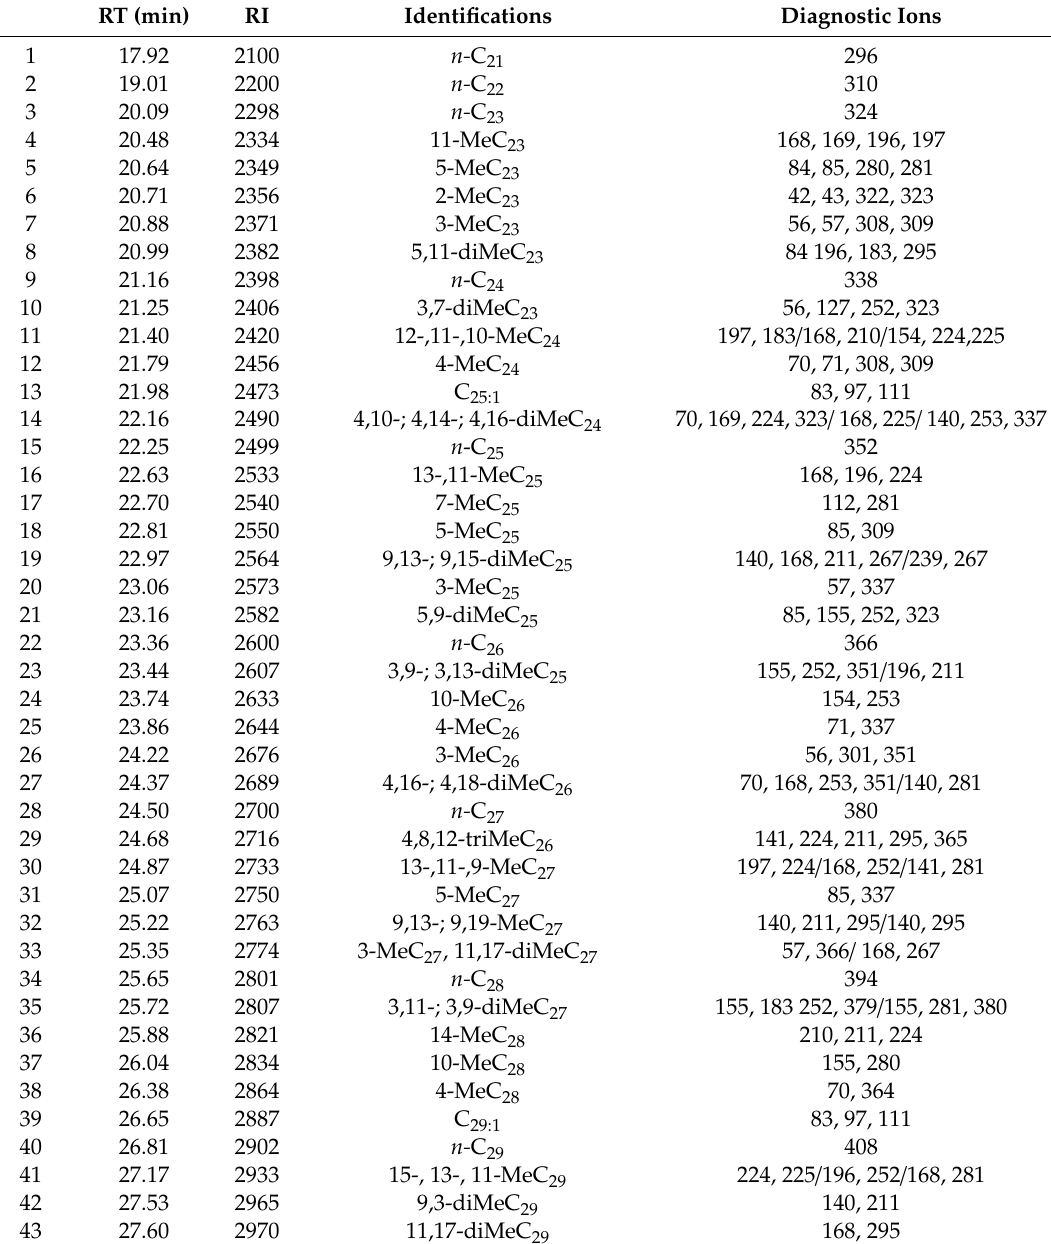
Table A1. Retention time (RT), Retention index (RI) and identification of compounds for all